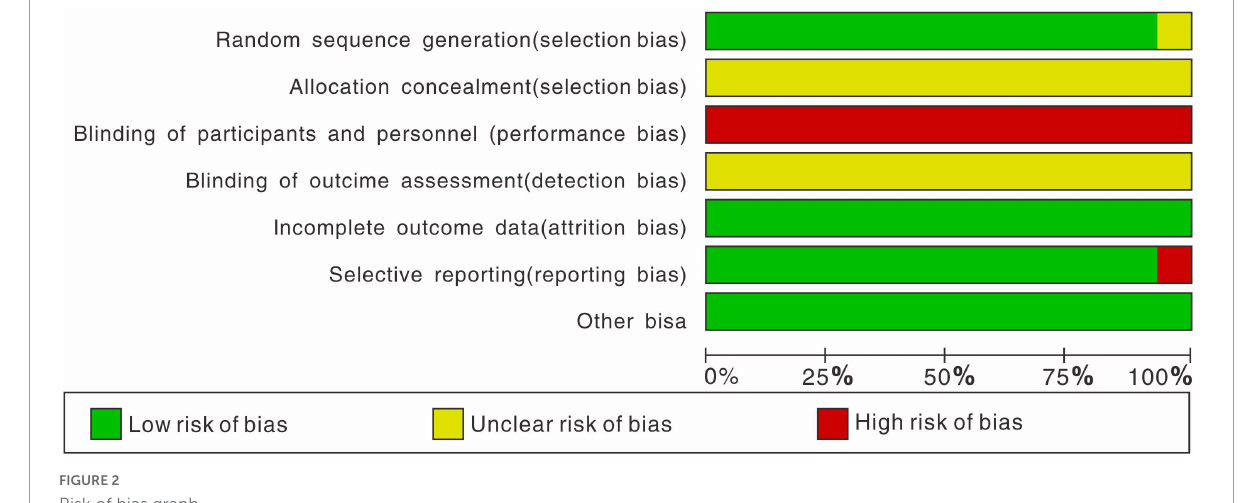
FIGURE2 Risk of bias graph.